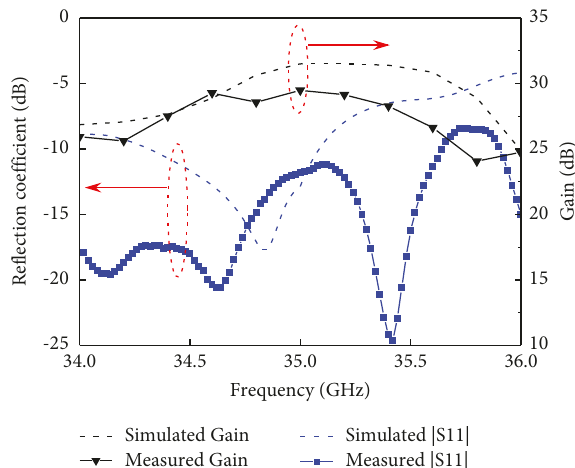
Figure 12: Simulated and measured results of reflection coefficient and gain.